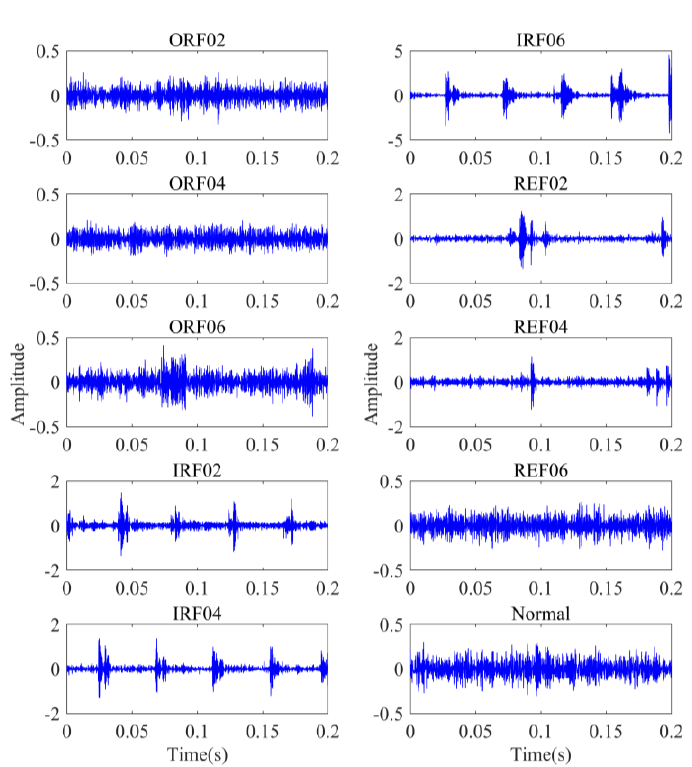
Figure 8. Bearing vibration signals under 10 different health conditions.